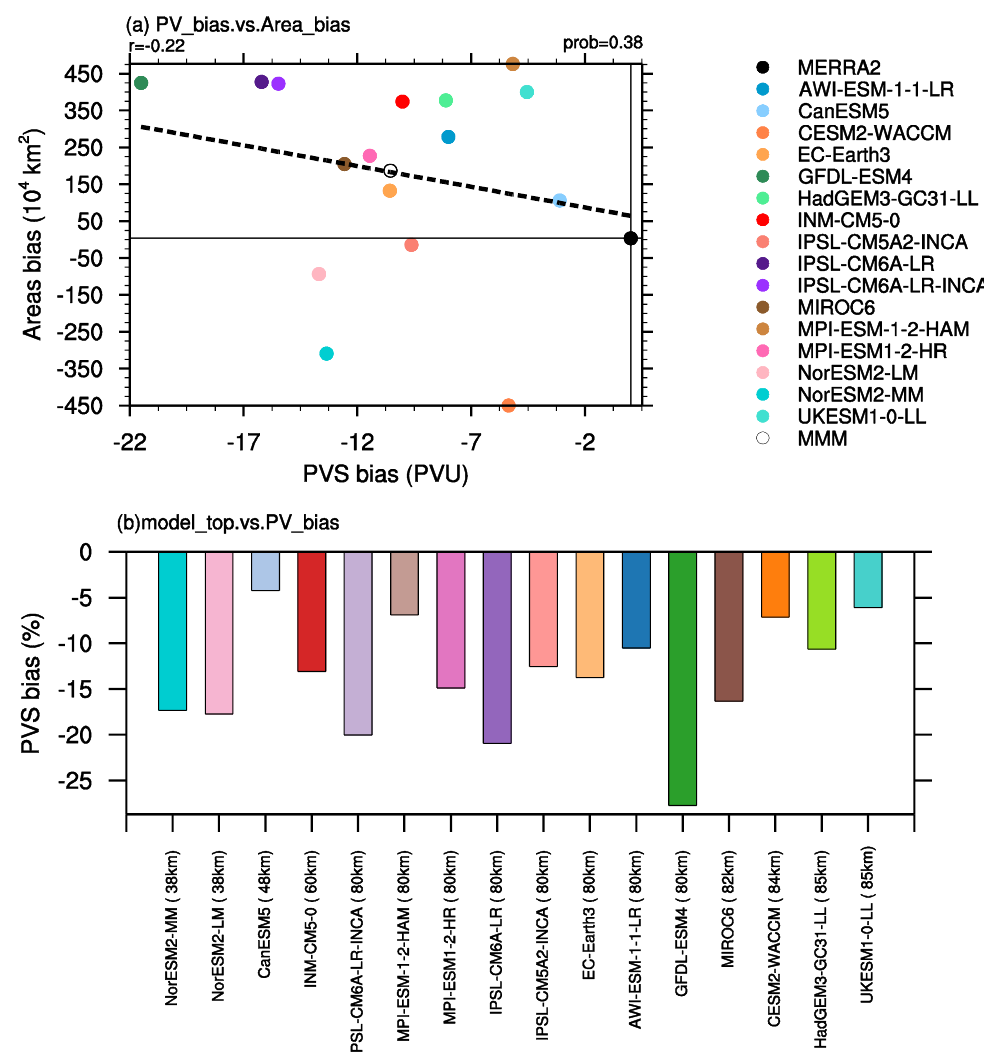
Figure 3. ( a ) Correlation between bias in polar vortex area and bias in polar vortex strength based on MERRA2 and 16 CMIP6 models for the period 1980/81 – 2013/14. ( b ) Ranking of polar vortex strength bias versus model top height of the 16 CMIP6 models. The ‘prob’ denotes the statistical significance according to Student’s t -test.